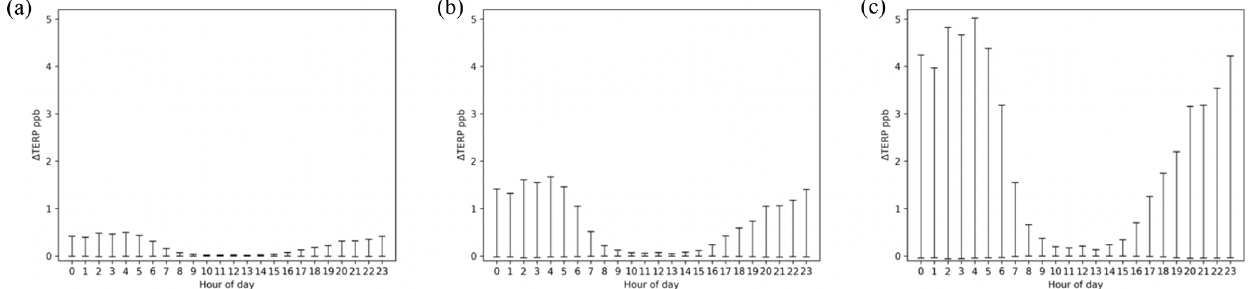
Figure 3. The hourly changes in TERP concentrations across the entire 4km × 4km domain, over the 90d simulation for the (a) 1_EC, (b) 5_DPW, and (c) 3_EC